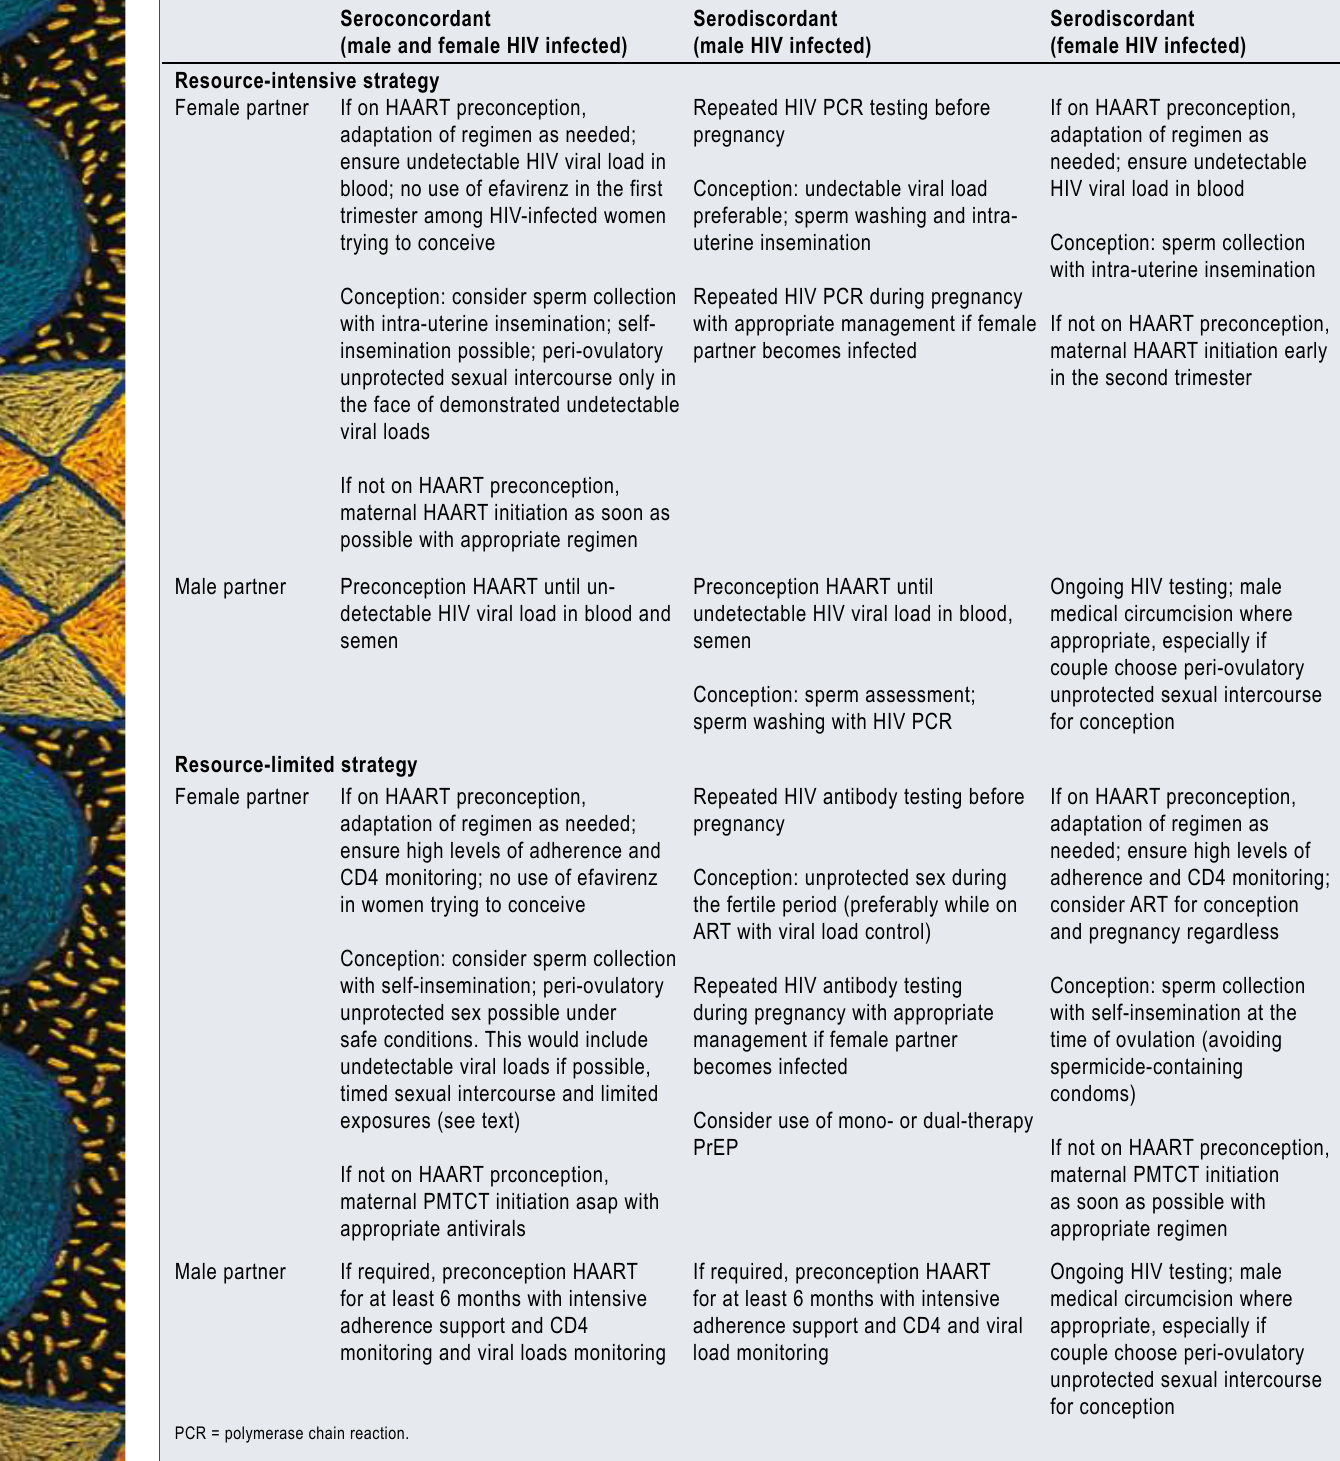
TABLE III. OPTIMAL CONCEPTION SUPPORT STRATEGIES FOR RESOURCE-INTENSIVE AND RESOURCE- LIMITED SETTINGS, ACCORDING TO THE HIV STATUS OF THE